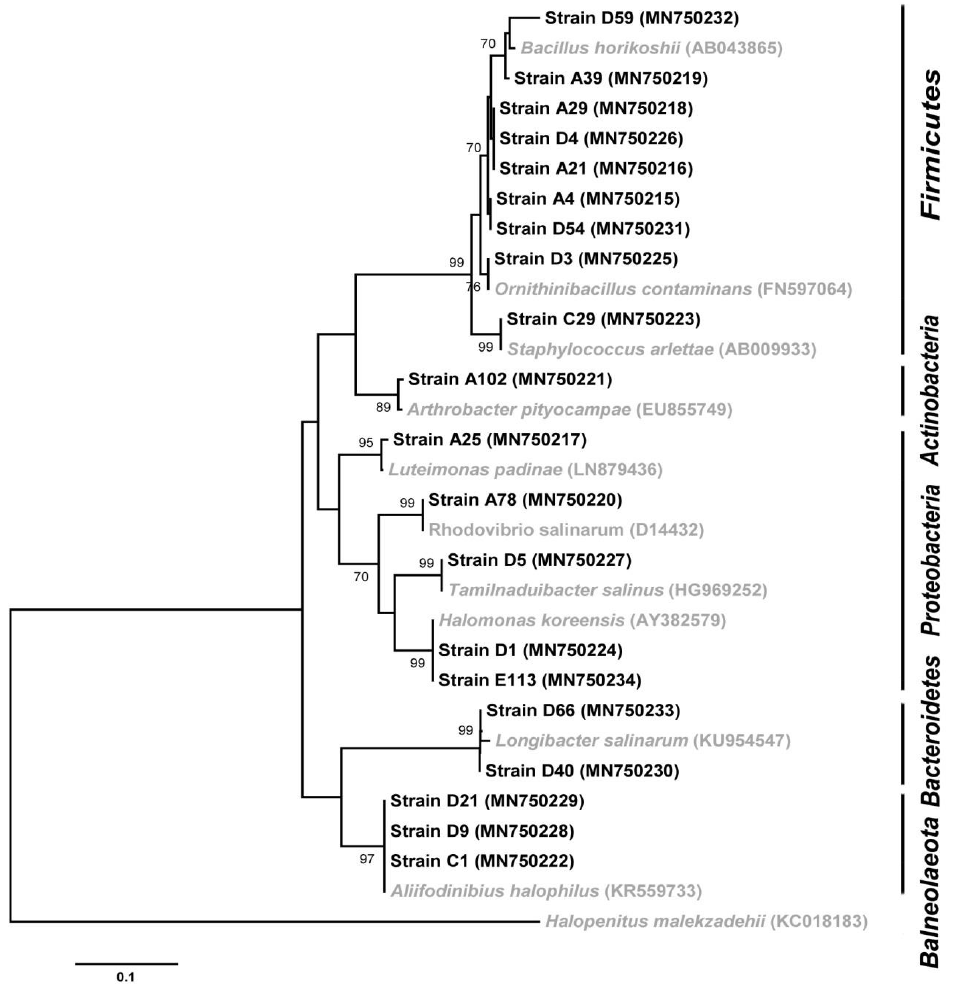
Fig. 2. Phylogenetic inferences based on 16S rRNA gene sequences from isolates belonging to the Bacteria domain. The tree is based on the neighbor-joining analysis. The sequence of Halopenitus malekzadehii was used as the